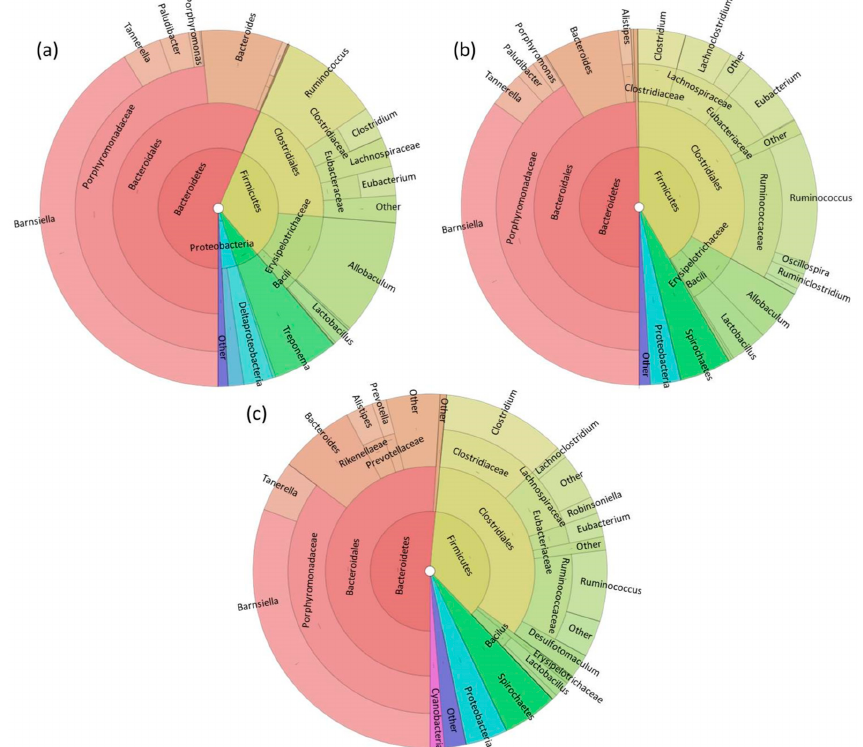
Figure 1. Cladogram-style pie charts (Krona charts) showing the average relative abundance of taxa in ( a ) colony diet, ( b ) colony-transitional diet, and ( c ) wild-captured diet fecal samples. All ‘other’ categories in each chart encompass taxa present at <1% abundance.